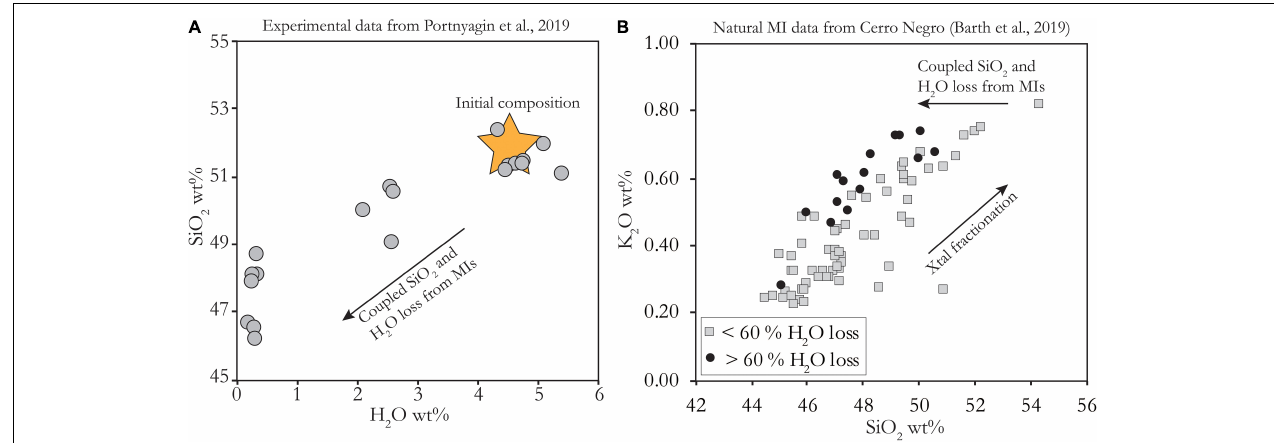
FIGURE 9 | (A) Experimental data from Portnyagin et al. (2019), showing coupled H 2 O-SiO 2 loss from MIs. Yellow star shows inferred initial composition based on high-Mg Klyuchevskoy basalts and H 2 O of fully rehydrated MIs. SiO 2 normalized to 100% on anhydrous basis to compare between MIs and whole rock. (B) natural data on MIs from Cerro Negro volcano, Nicaragua (Barth et al., 2019). Broad trend of increasing K 2 O with SiO 2 is driven by crystal fractionation. MIs for which large amounts of diffusive water loss were calculated (as in Figure 8 ) are offset to lower SiO 2 than those with less calculated water loss. Concentrations are as measured (uncorrected for PEC, not normalized to 100% anhydrous) but these corrections do not affect systematics.